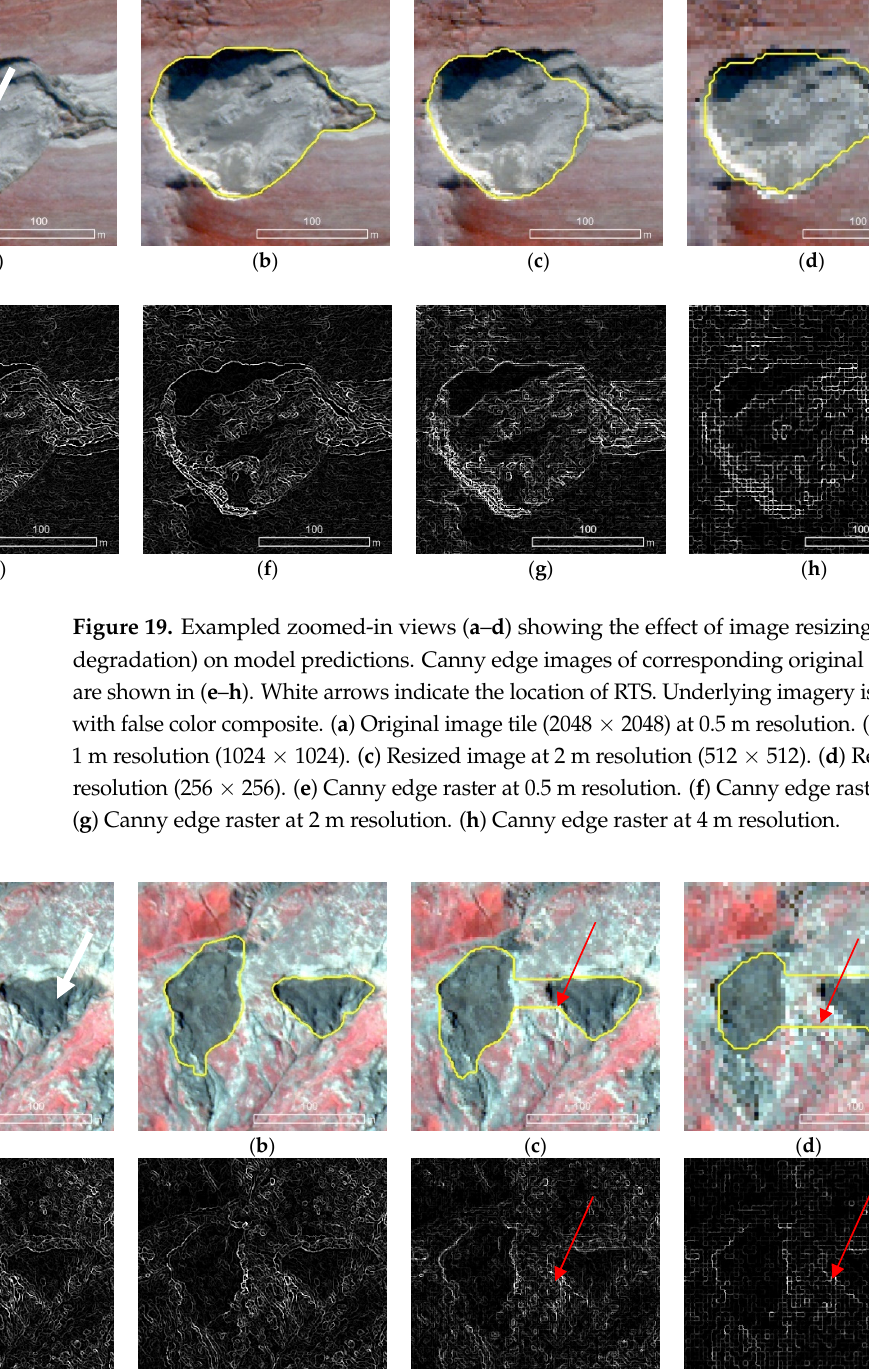
( i ) Figure 18. Example zoomed-in views of DLCNN model predictions on the test data from selected location of Banks Island and the Eureka Sound Lowlands. Examples show training and prediction of input image tiles of 512 × 512 ( a , d , g ) without resizing 512 × 512 ( b , e , h ) and with resizing into one network input size: 256 × 256 ( c , f , i ). Outline of the predicted RTS is shown in yellow outline. White arrows indicate the location of RTS. Underlying imagery is at 0.5 m resolution as false color composites. A closer inspection on Figure 17 can provide further insights to understand the relationship between the RTS object size and the resizing factor. In this case, the image tiles of 1024 × 1024 resolution have progressively been resized to two network input sizes (512 × 512 and 2565 × 256). For large RTS objects, the shape and geometrical congruency are mostly intact despite the increasing resizing factor (see Figure 16f–h). Figure 18 illustrates the model prediction results pertaining to the image tiles of 512 × 512 and 256 × 256. Zoomed-in views shown in Figures 19–23 aim to further explain how the resizing factor affect the DLCNN model performances. In the cases shown in Figures 21 and 22, the spatial footprint size of the image tile is preserved. However, the spatial resolution (0.5 m) is down-sampled to match different network input sizes. We employed the Canny edge detection algorithm on the original image tile and the resized images to visualize the changes in high frequency information (i.e., edges). For large, homogenous, well- pronounced, and spatially discrete RTS objects (see Figure 21), the impact of resizing